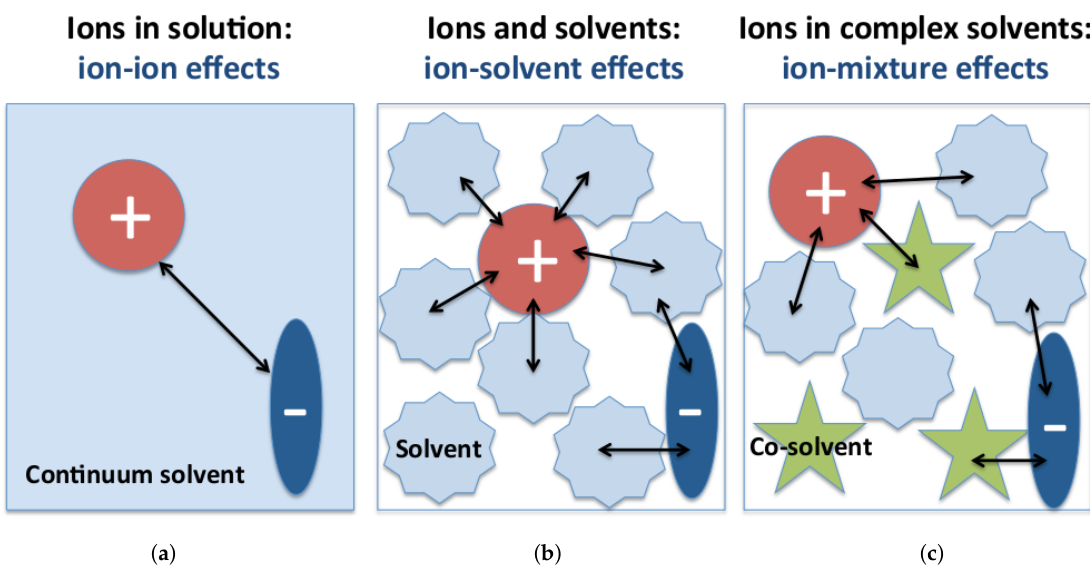
Figure 1. Schematic representation of interactions between ions and further components in electrolyte solutions at different levels of detail: ion–ion electrostatic interactions in a continuum solvent approach ( a ); interactions between ions and solvent molecules at molecular resolution ( b ); and ions in presence of complex multicomponent solutions with mixtures of co-solvent or additive molecules ( c